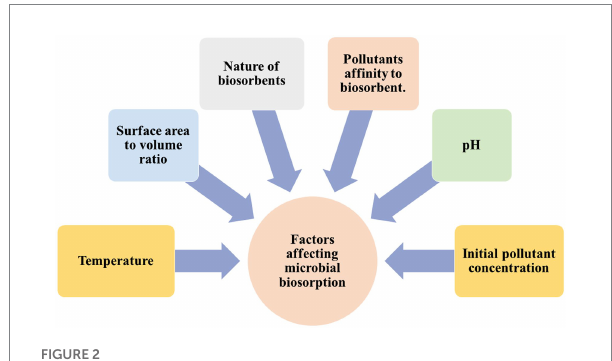
FIGURE 2 Factors for effective biosorption of pollutants.